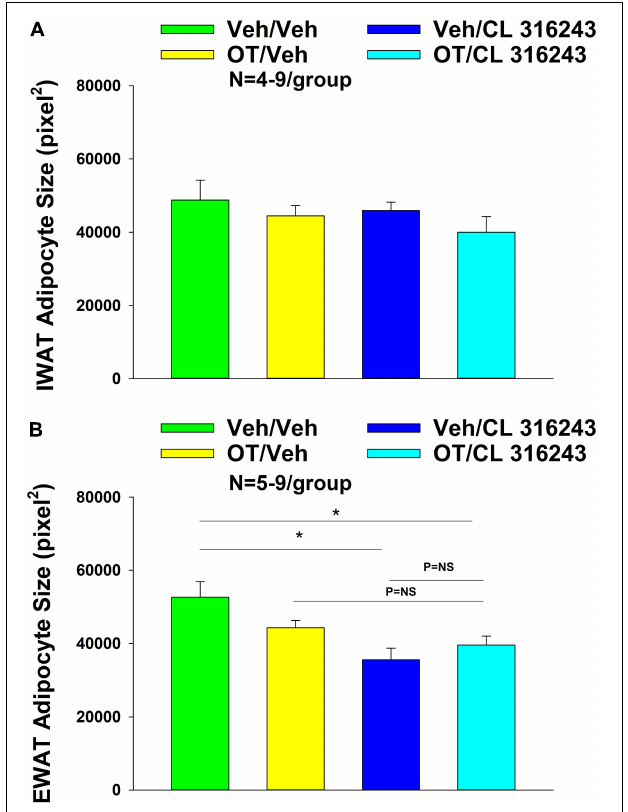
FIGURE 4 | (A–H) Effect of chronic 4V OT infusions (16 nmol/day) and systemic beta-3 receptor agonist (CL 31643) administration (0.5 mg/kg) on adipocyte size in IWAT and EWAT in male DIO rats. Adipocyte size was analyzed using ImageJ. Images were taken from fixed (4% PFA) paraffin embedded sections (5 µ m) containing IWAT (A–D) or EWAT (E–H) in DIO rats treated with 4V OT (16 nmol/day) or 4V vehicle in combination with IP CL 316243 (0.5 mg/kg) or IP vehicle. A/E, Veh/Veh; B/F, Veh/CL 316243; C/G, OT/Veh; D/H, OT-CL 316243; (A–H) all visualized at 100 × magnification.